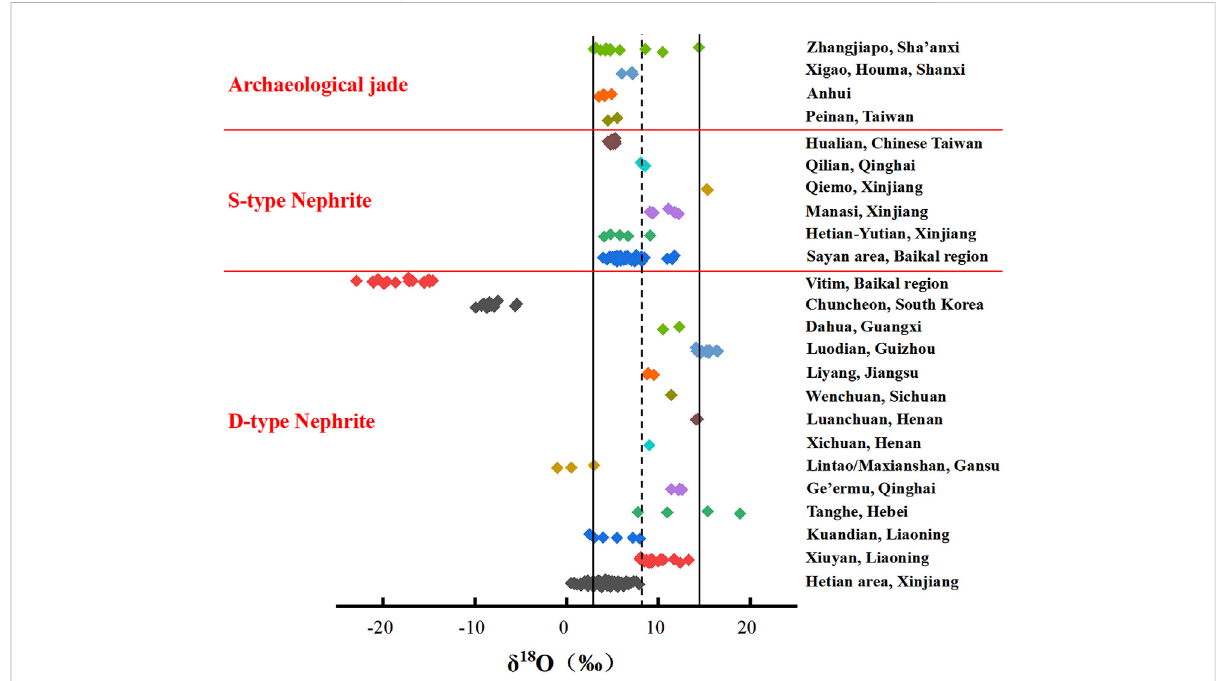
FIGURE 8 Comparative analysis of oxygen isotopes between modern nephrite deposits and excavated jadewares (The range of black lines represents the oxygen isotope values of excavated jadewares, and the dashed line represents the lower limit of oxygen isotope values of most D-type